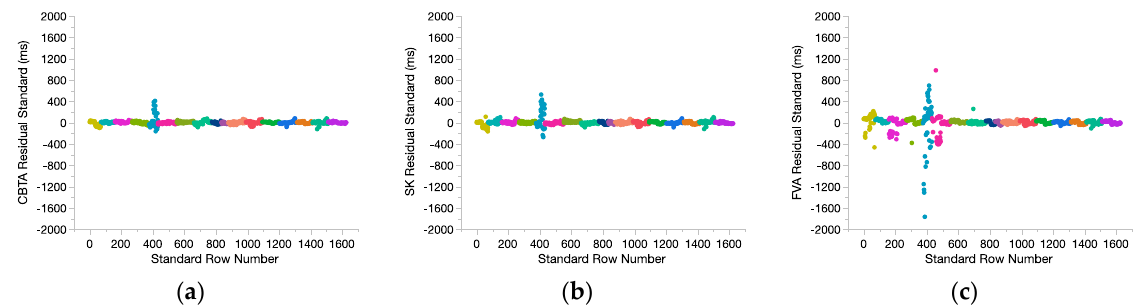
Figure A1. Gait event time residuals (ms) when detected with different kinematic methods for each subject. Blue data points illustrate one individual with the largest residuals in each plot. ( a ) coordinate-based treadmill algorithm (CBTA); ( b ) shank angular velocity algorithm (SK); ( c ) foot velocity algorithm (FVA).